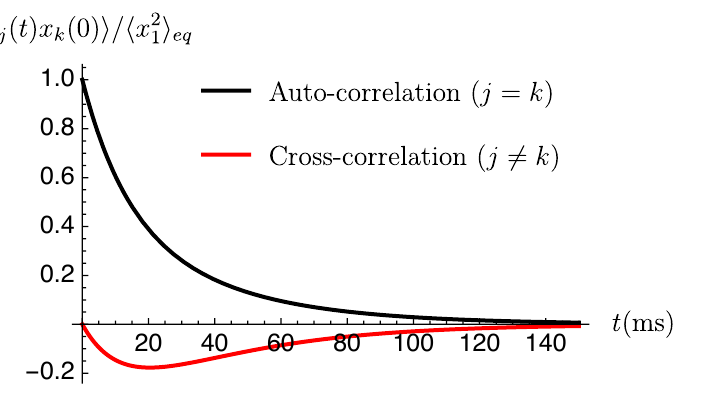
〉 as a function eq 1